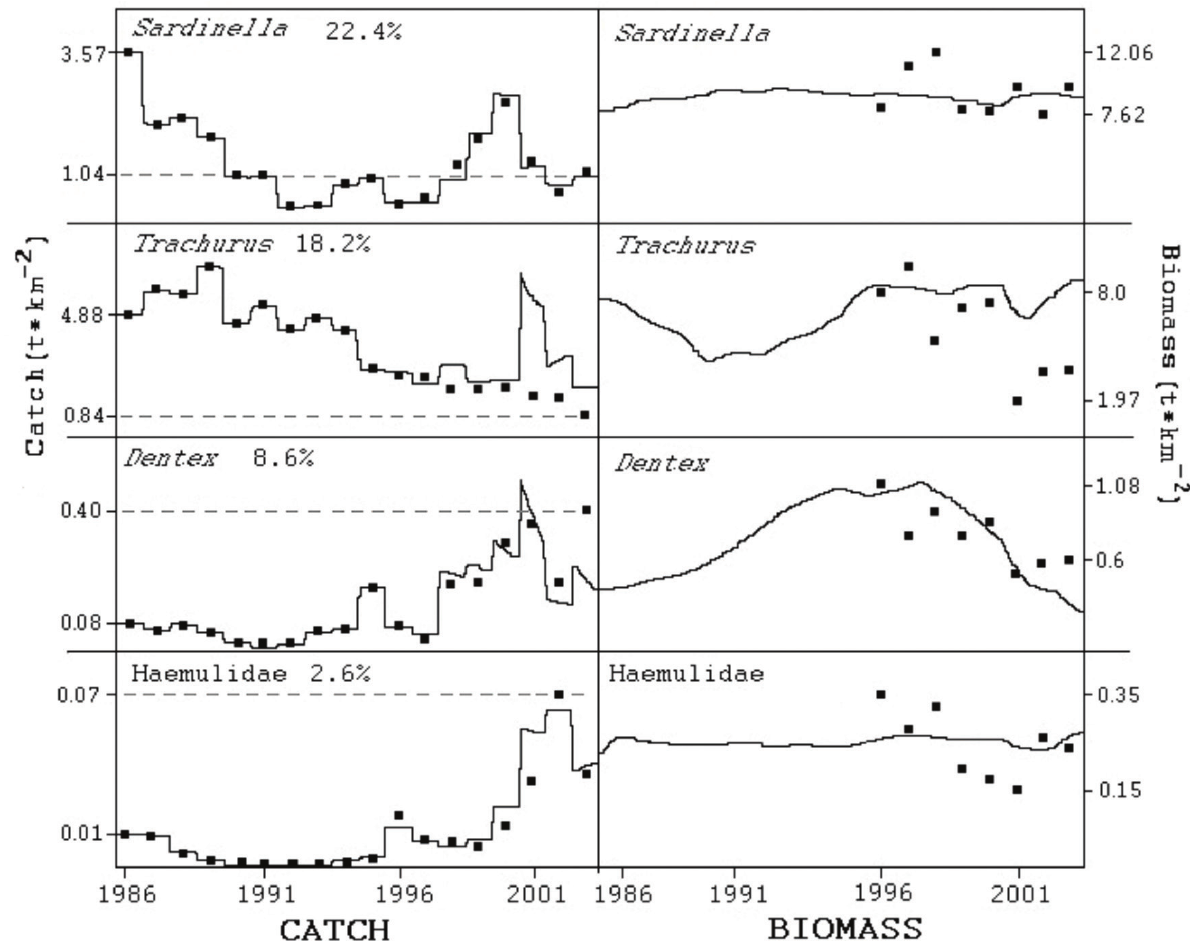
Fig . 3. – Catch (left panels) and biomass (right panels) for the main fishing groups in the Angolan model. Dots are observed values and lines simulated values (catch data from FAO, 2000, 2006; biomass data from Duarte et al. , 2005). Percentage values are presented in relation to total landings in